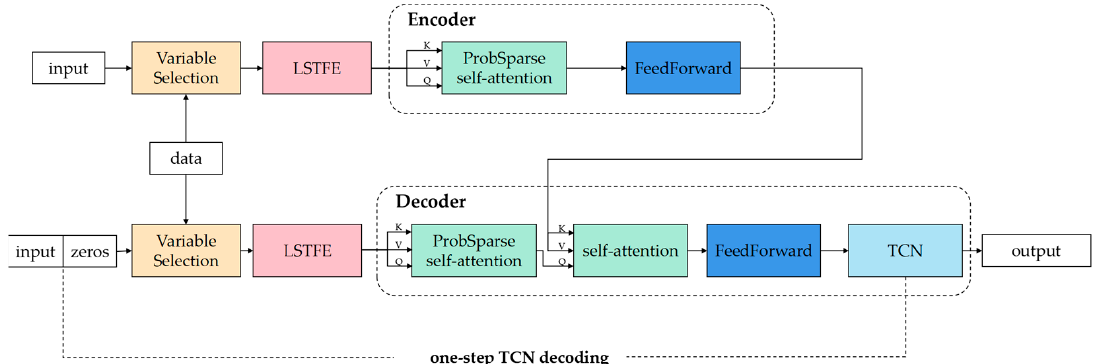
Figure 3. The structure of TCNformer model.